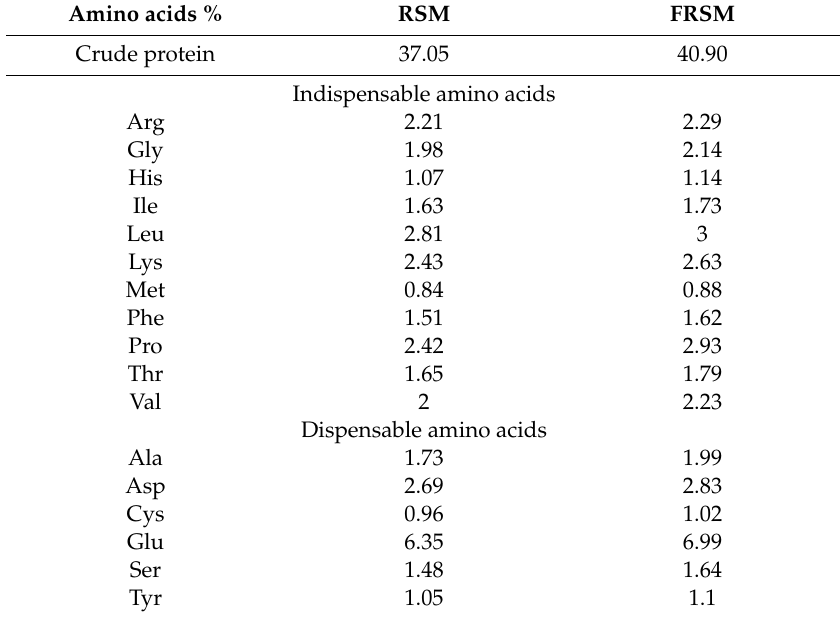
Table 3. Amino acids composition of fermented rapeseed meal (FRSM) and rapeseed meal (RSM) (dry matter basis).